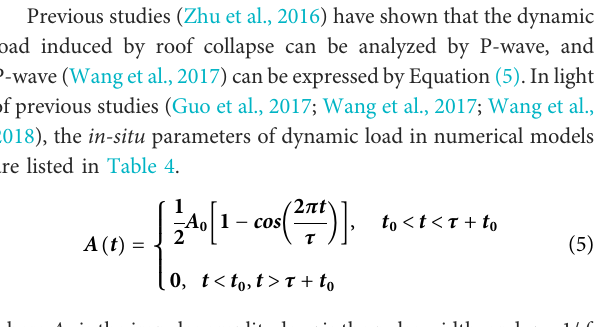
FIGURE 7 Schematic diagram of the numerical